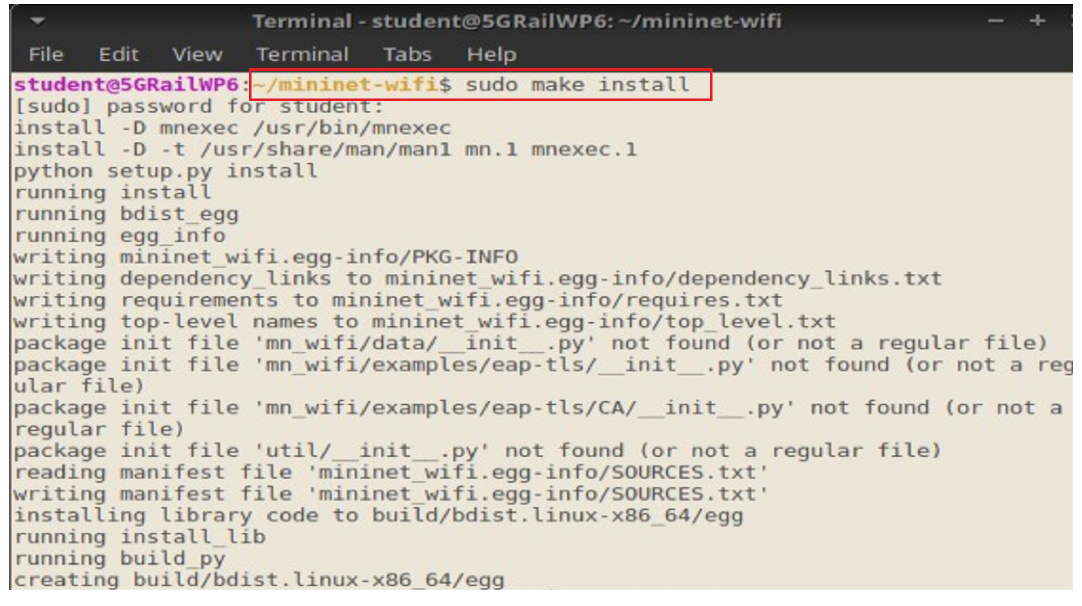
Figure 46. Save all the